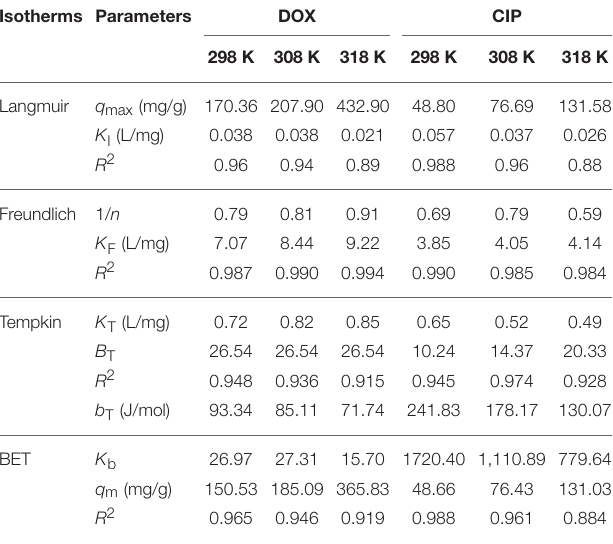
TABLE 2 | The model parameters and the corresponding correlation coefficient of isotherm models. Isotherms